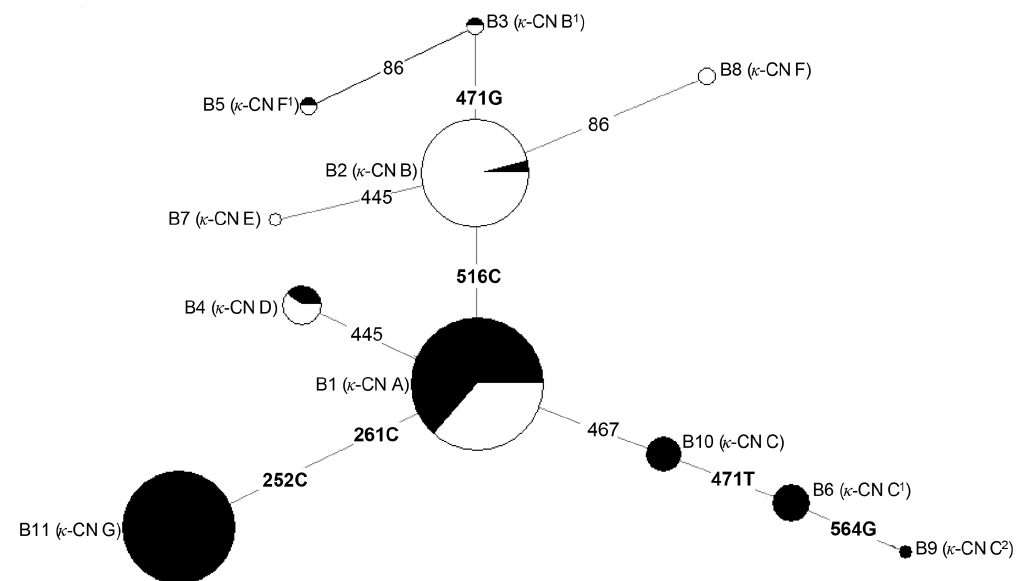
Figure 4. Network profile of 11 buffalo haplotypes of the buffalo CSN3 gene. B1–B11 are the haplotypes defined in water buffalo. Mutations along the branch are labeled by the nucleotide positions; transversions are specified by further adding suffixes A, G, C and T. Each haplotype is represented by a circle, with the area of the circle proportional to its frequency. Samples from river and swamp buffalo are indicated by black and white color,